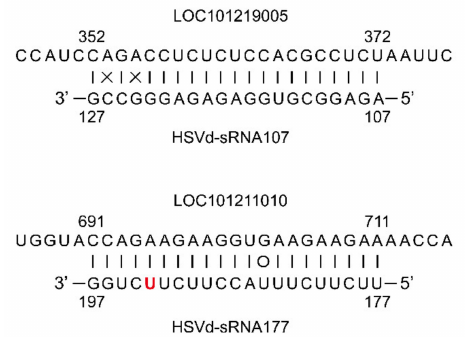
Figure 9. Two predicted target genes of HSVd-sRNAs. Complementary basepairs between HSVd-sRNA107 and HSVd-sRNA177 and their predicted target genes. LOC101219005 encodes an ethylene-responsive transcription factor ERF011; LOC101211010 encodes a trihelix transcription factor GTL2. Targeted host mRNAs are on top (5’–3’ orientation) and sRNAs below (3’–5’orientation); | , Watson-Crick base pairs; o, G:U wobble base pairs; × , mismatches. Positions of the respective 5 (cid:48) - and 3 (cid:48) -terminal nucleotides are indicated. The nucleotide in red color indicated the adaptive mutation at position